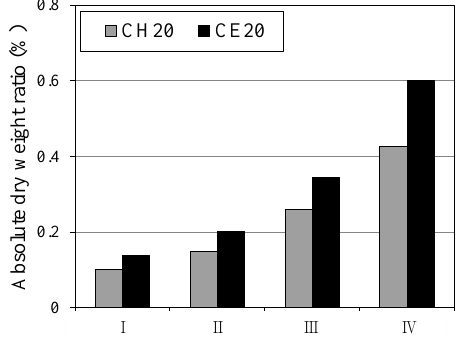
Materials 2019 , 12 , x; doi: FOR PEER REVIEW Figure 6. Absolute dry weight ratio (20 ◦ C). Figure 6. Absolute dry weight ratio (20 °C).